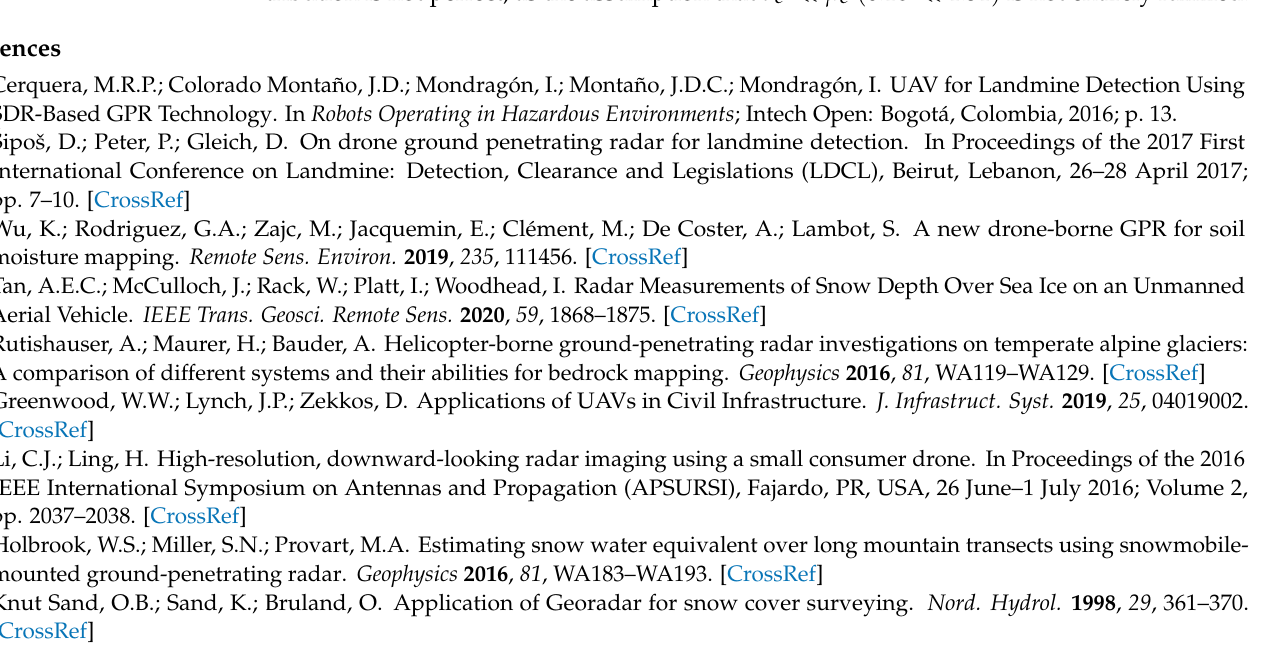
Figure A1. Histogram of dielectric constant (cid:101) from 100,000 realizations. Solid line: Gaussian approxima- tion from Equation (A8). Mean value and standard deviation are µ (cid:101) = 1.51 and σ (cid:101) = 0.16, respectively. Observe that the fit between the histogram and the theoretical approximate Gaussian dis- tribution is not perfect, as the assumption that σ (cid:101) (cid:28) µ (cid:101) ( 0.16 (cid:28) 1.51 ) is not entirely